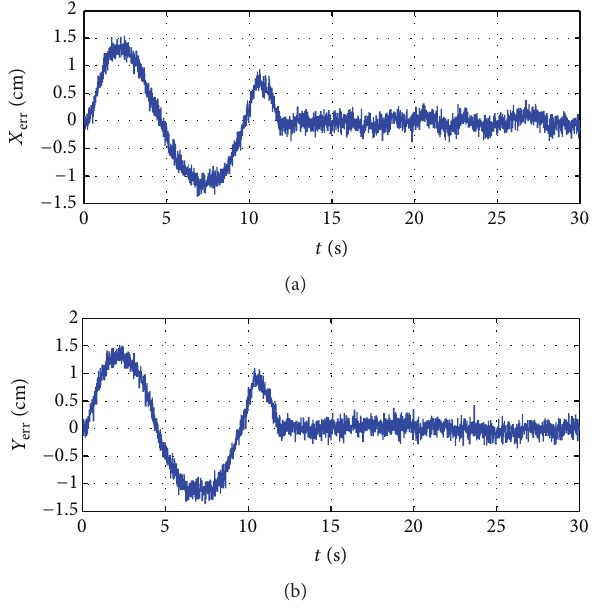
Figure 9: Position tracking errors: (a) along the x- axis, (b) along the y